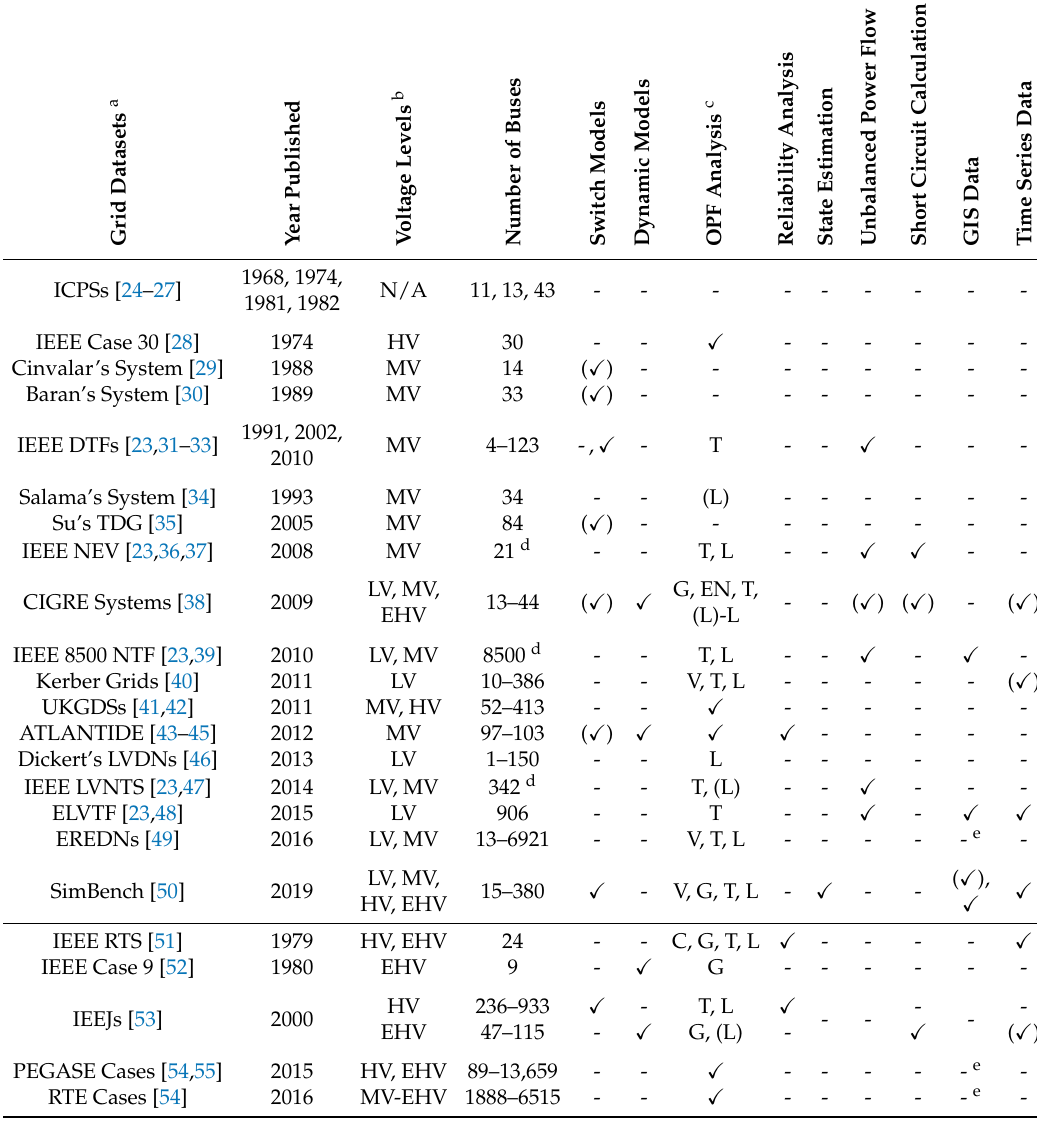
Table 1. Overview of grid data properties and possible analyses types of publicly available, widely used distribution grids ( top ) and four exemplary transmission grids ( bottom